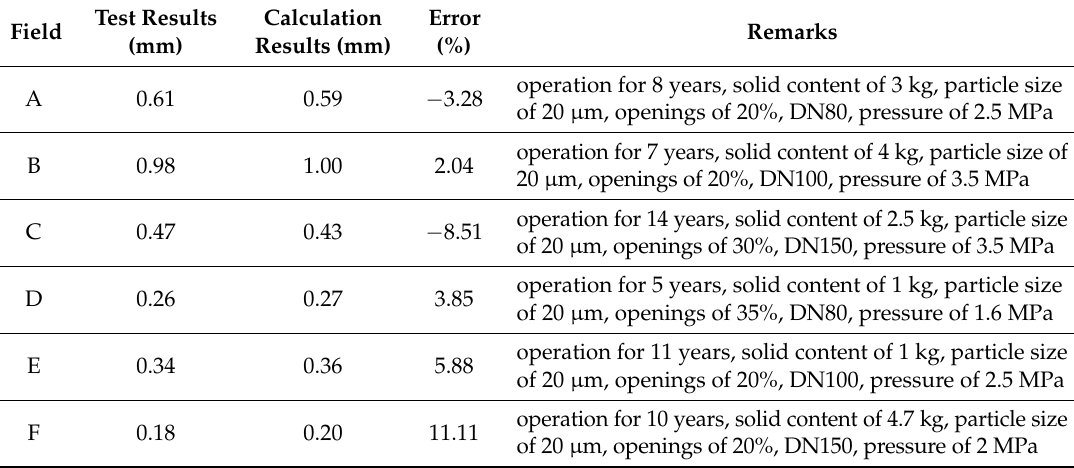
Table 4. Verification results of the maximum erosion rate with field test data in Chongqing area.